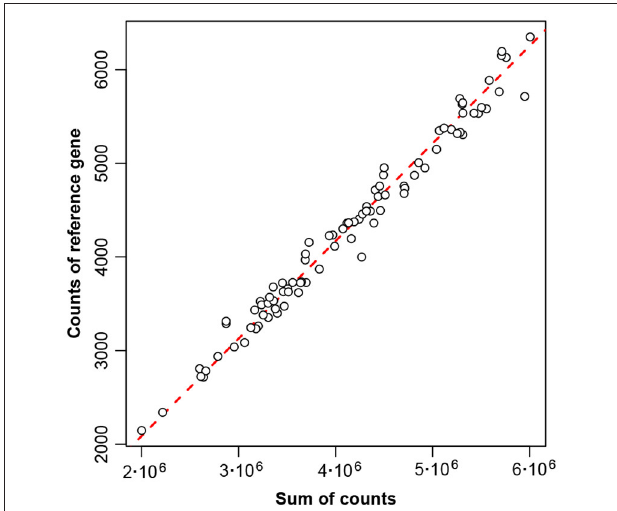
FIGURE 4 | Proportionality between counts of reference gene number 856 and sum of counts, for the 89 samples of the Rabbits data. The diagonal line of exact proportionality goes through the origin (0,0).